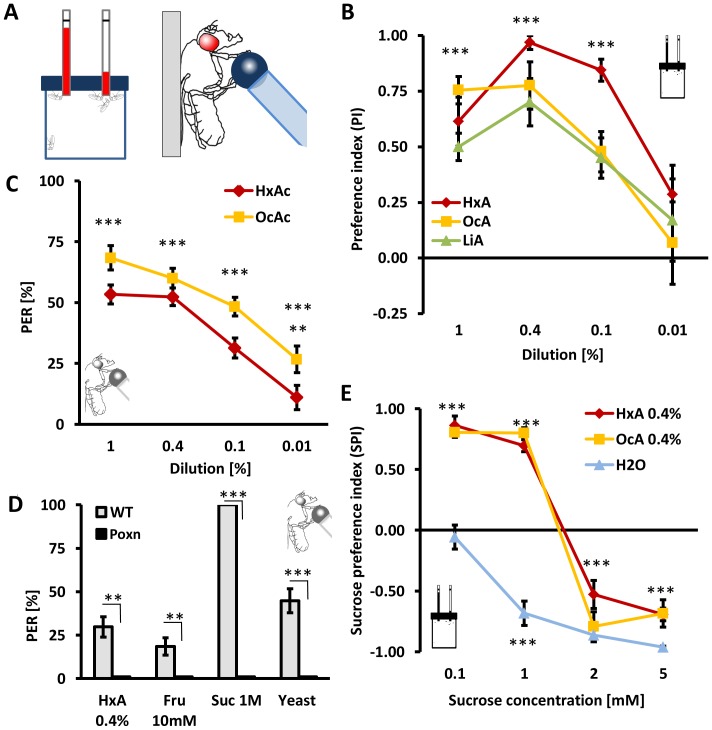
Fatty acids are appetitive tastants.A) Left: Capillary feeding assay CAFE provides flies a choice between a nutrient and control tube. Right: In Proboscis extension reflex (PER) assay, flies are stimulated with a tastant on their feet and they respond with extension of their proboscis to appetitive substances in attempt to feed. The probability of their response is proportional to the level of starvation and the hedonic value of the substance. B) HxA, OcA, LiA acids are preferred over water in CAFE at concentrations ranging from 1–0.1%. C) The PER elicited in response to presentation of HxA or OcA. Concentrations of 1% to 0.01% elicit significant PER responses that are concentration dependent. D) Poxn mutants lack all peripheral taste neurons and show no response to HxA, fructose, sucrose or yeast. E) Appetitive response to FAs in two-choice feeding assay is comparable to low concentrations of sugars and is concentration dependent. Intake of 0.4% HxA and 0.4% OcA were measured against different concentrations of sucrose. Flies prefer sucrose to water at concentrations of 0.5 mM or greater but prefer 0.4% HxA and 0.4% OcA to 1 mM sucrose or lower, while sucrose is preferred at concentrations of 2 mM and greater (p<0.001). All data, mean ± s.e.m. ** p<0.01, *** p<0.001; NS, not significant, t-test.